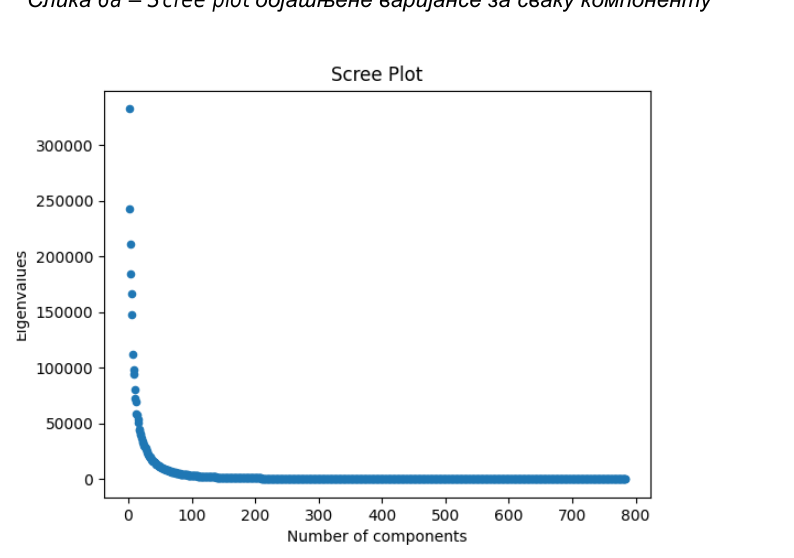
Figure 6b – Scree plot of the eigenvalues for each component Рис. 6б – График осыпи собственных значений каждого компонента Слика 6б – Scree plot сопствених вредности за сваку